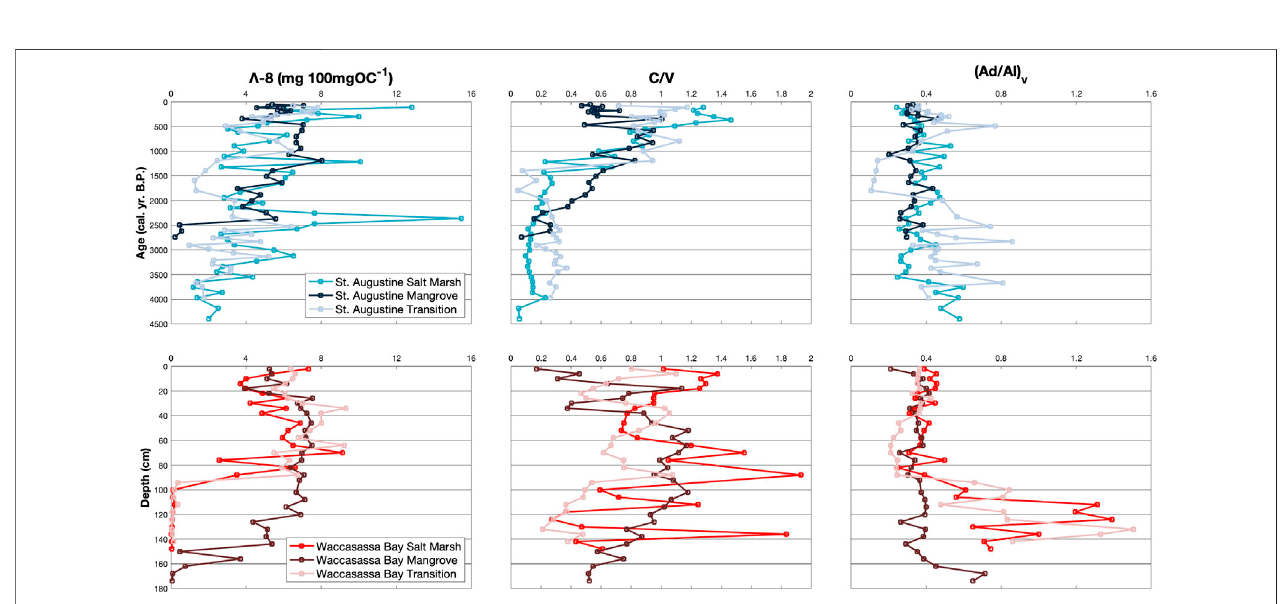
FIGURE 3 | Down-core measurements of Λ -8 (mg 100mgOC − 1 ), C/V, and (Ad/Al) v for cores in St. Augustine (top) and Waccasassa Bay (bottom) . St. Augustine cores are plotted against calibrated ages (cal. yr. B.P.) and Waccasassa Bay cores are plotted against depth (cm).